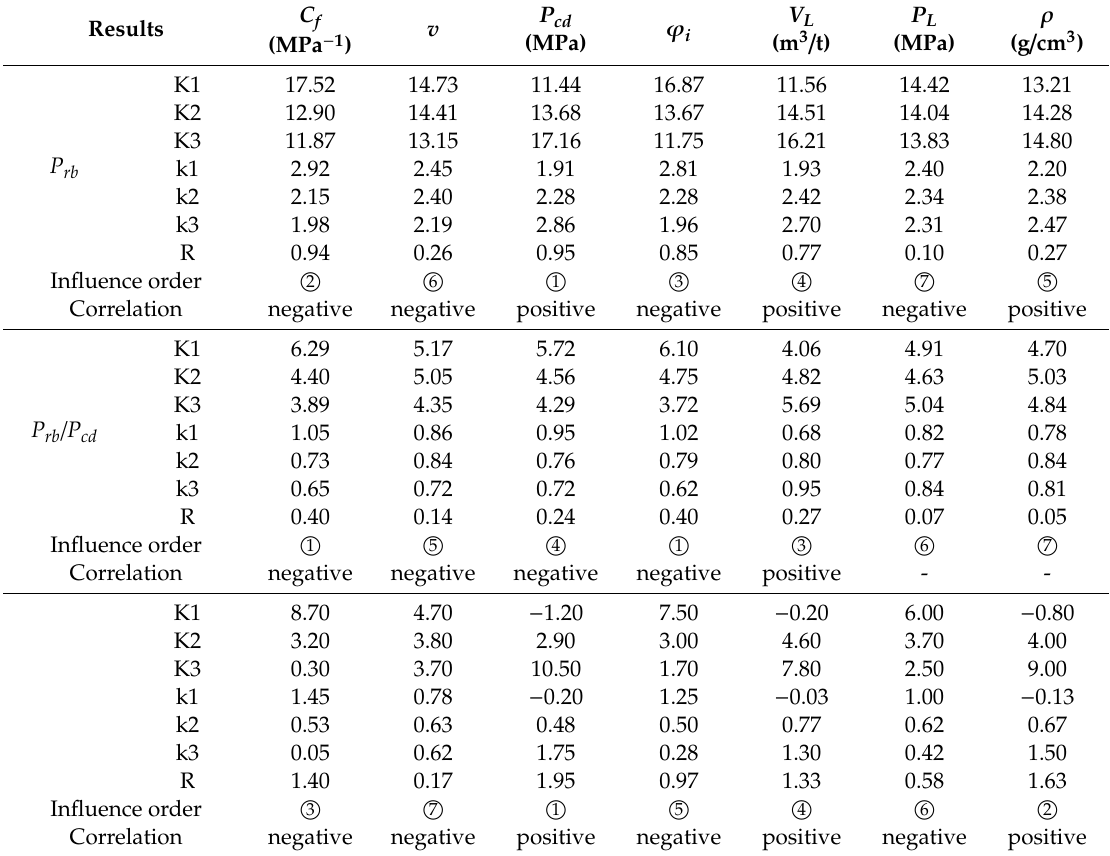
Table 4. The orthogonal test